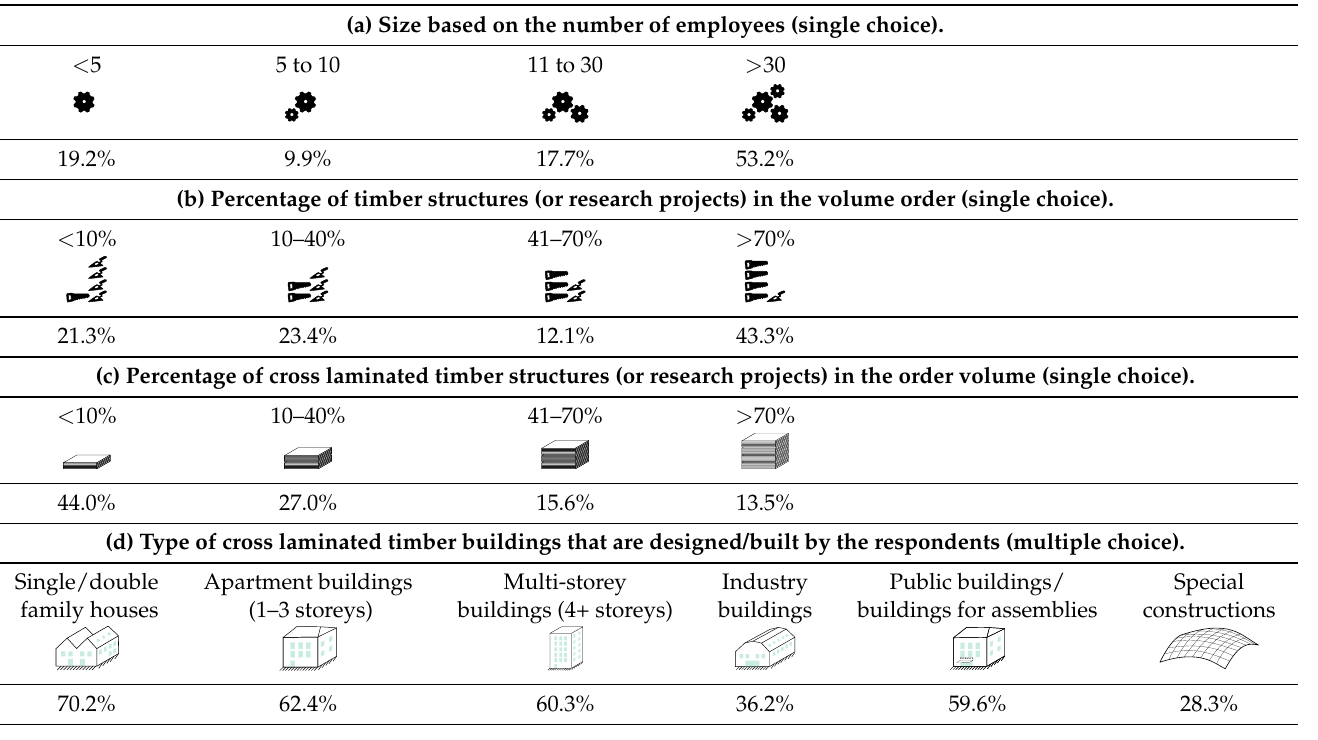
Table 2. Data of the companies of the